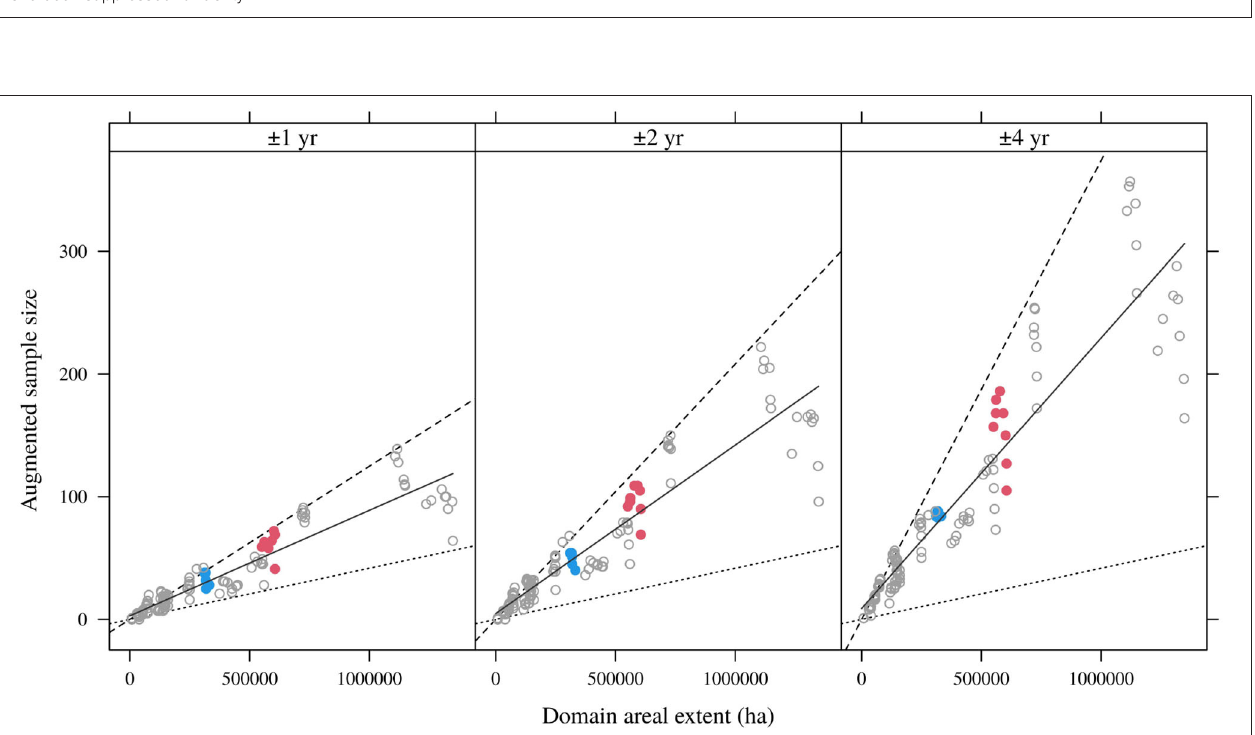
FIGURE 6 | Augmented sample sizes and domain areas for 10-year domains (all lags) and different lag buffers ( δ sampling intensity r 1 : 24,000; dashed lines are augmented intensities (2 δ ≈